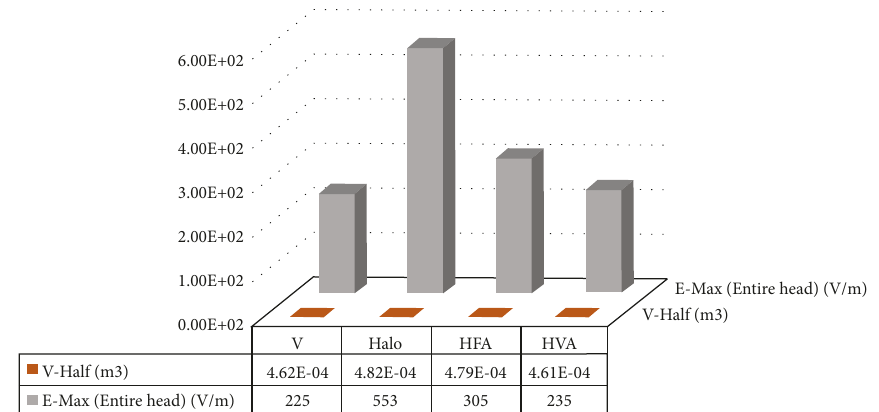
Figure 13: Focality measurement of single and assembly coils in terms of V-half and maximum electric